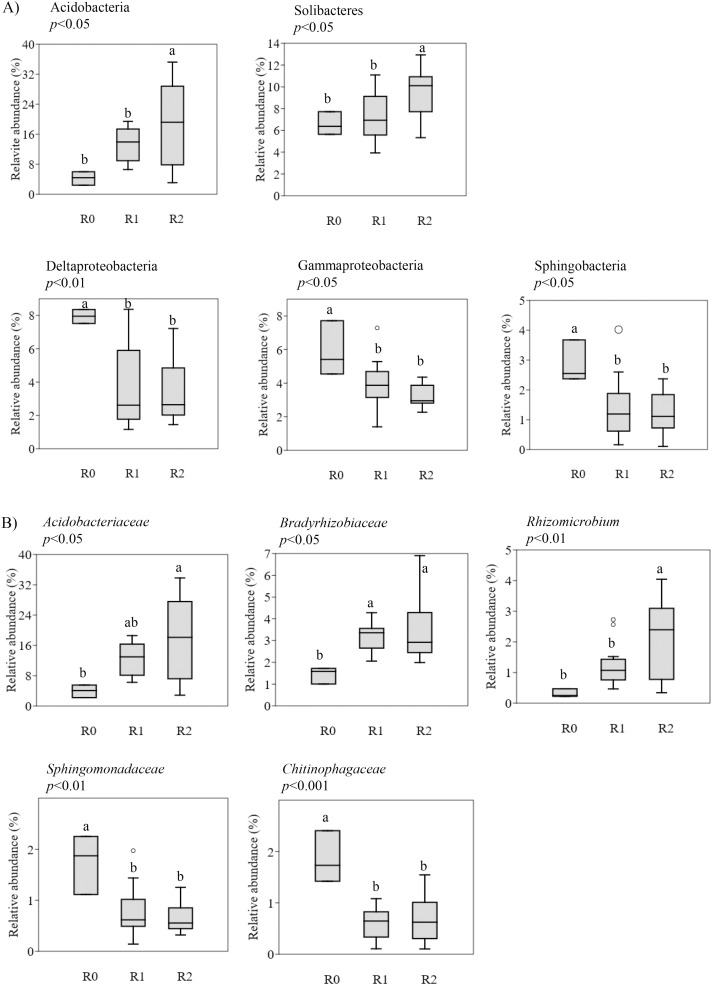
Changes in bacterial populations according to rounds of cultivation.(A) Boxplots indicate bacterial classes, (B) Boxplots indicate bacterial families. R0, non-cultivation; R1, first round of cultivation; R2, second round of cultivation. The p-values were generated by one-way ANOVA, post hoc Tukey’s test. “a” and “b” indicate significant differences between the round of cultivation (p<0.05).